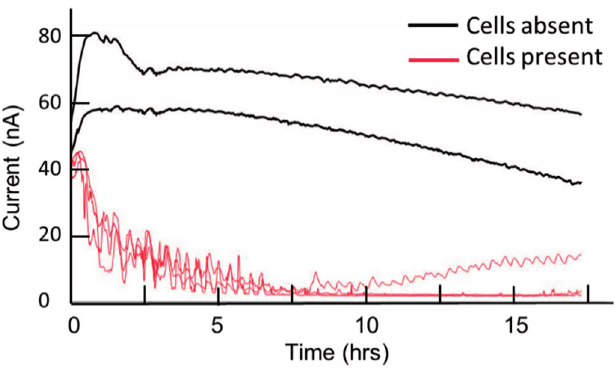
Figure 8. Amperometric responses obtained for five collagen-coated glucose microbiosensors run over 24 h. Wells contained 340 µL of culture medium in the absence or the presence of 2 × 10 5 BeWo cells. E app = +0.4 V; Temp = 37 °C; 5% CO 2